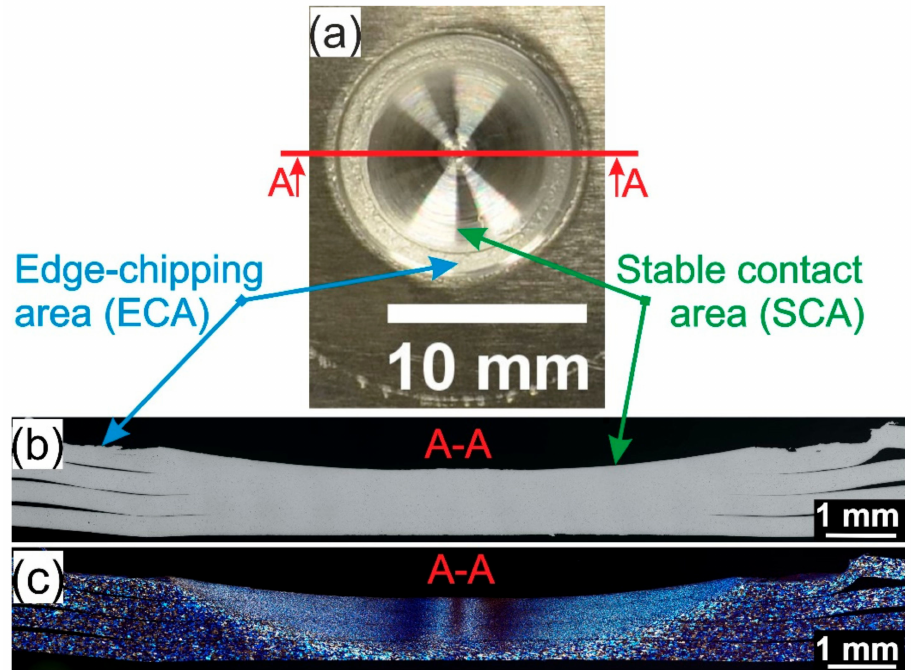
Figure 4. Sample welded at 1500 rpm and with tool T2 (batch II): ( a ) top view macrograph, ( b ) polished and ( c ) etched cross-section views of the welded joints.